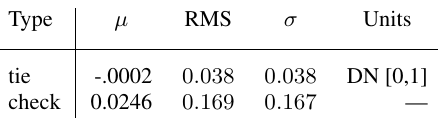
Table 2: Residuals (radiometric tie points) and differences (radio- metric check